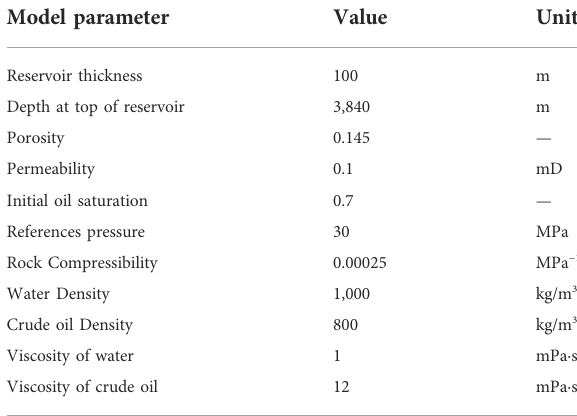
TABLE1Valuesofreservoirpropertiesand fl uidpropertiesparameters in the research area.